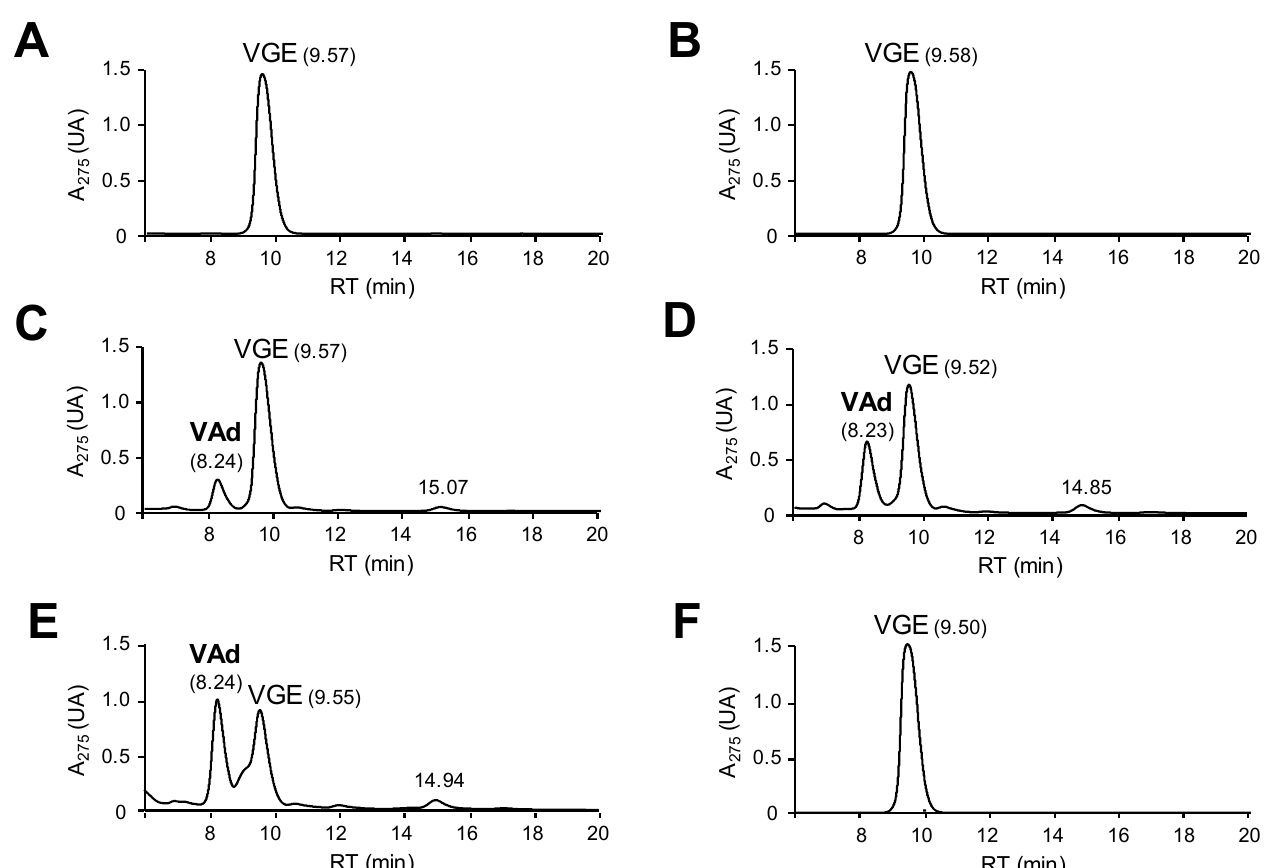
Figure 2. LC analysis of VGE (1 mM) reactions with 4.4 µM Asp DyP2 ( A ), Tcu DyP ( B ), Aau DyP ( C ), Per VPL ( D ) and Pch LiPA ( E ), and control without enzyme ( F ), in 100 mM tartrate, pH 3, containing 1 mM H 2 O 2 . The reactions were incubated for 1 h at 25 ◦ C and 300 rpm, and stopped with sodium azide before analysis. Veratraldehyde (VAd) formation was observed in ( C – E